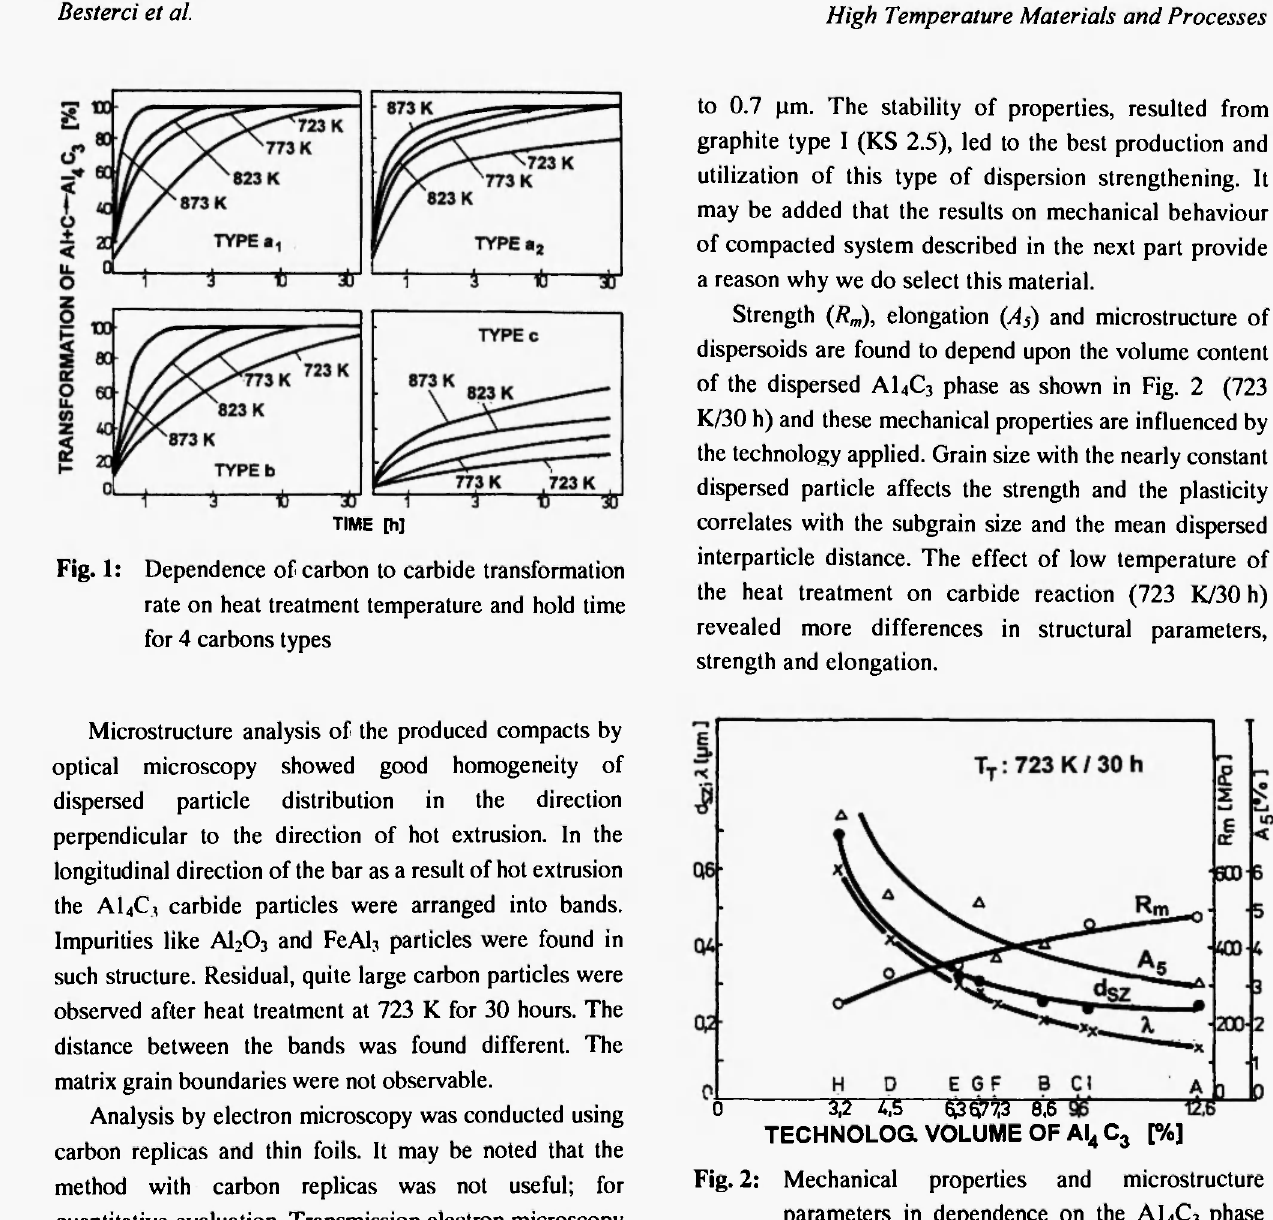
Fig. 2: Mechanical properties and microstructure parameters in dependence on the AI4C3 phase content after heat treatment 723 K/30